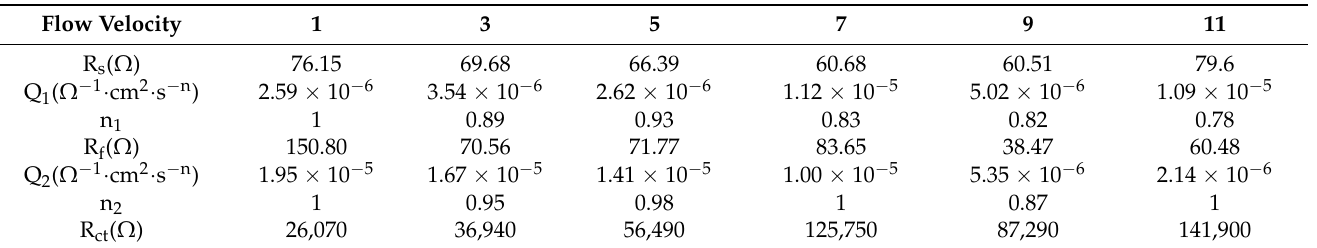
Figure 10. Equivalent circuit diagram. Table 3. Fitting parameters of equivalent circuit components of 304L stainless steel at different flow velocities.